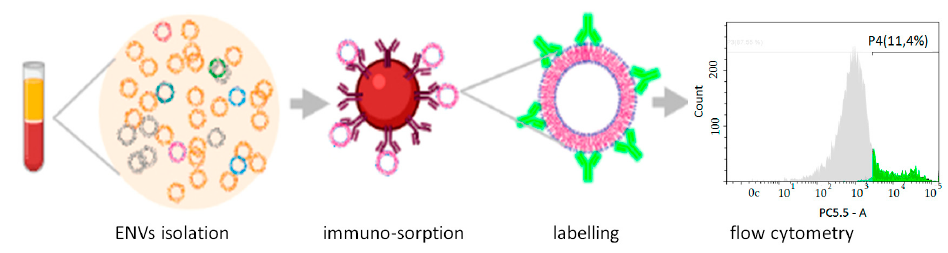
Figure 2. Workflow of colon-derived ENV isolation and analysis.